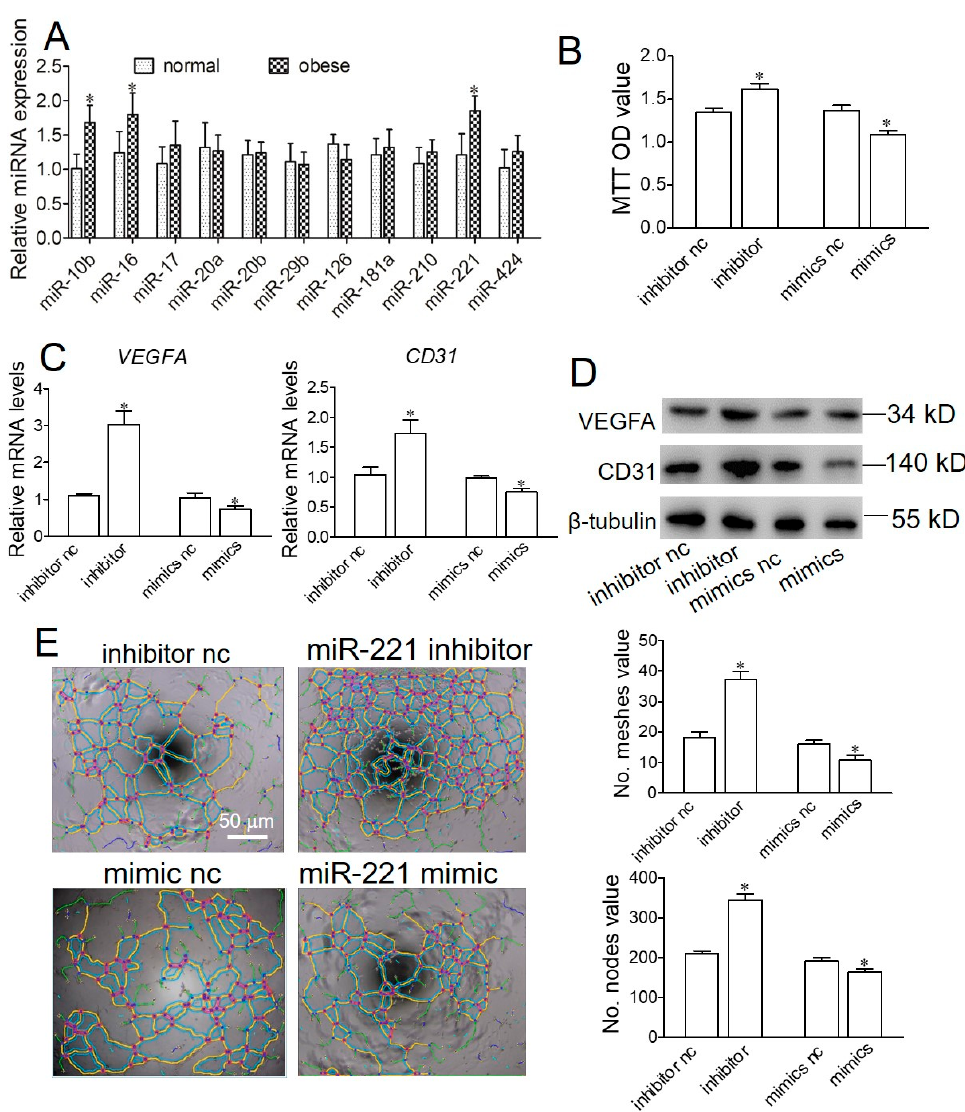
Figure 4. Obese sow exosomal miR 221 is secreted and impairs angiogenesis. ( A ) The expression levels of angiogenic miRNAs in plasma from normal (white columns) and obese (gray columns) sows were measured by qPCR. ( B ) Cell pro- liferation was examined using MTT after transfection with miR-221 inhibitor or miR-221 mimic. ( C ) qPCR was performed to detect the mRNA expression of VEGFA and CD31 . ( D ) Western blotting was conducted to detect the protein expression of VEGFA and CD31. ( E ) Images of tube formation were examined in endothelial cells. Values are means ± SD (n = 6 preparative replicates). * p < 0.05.